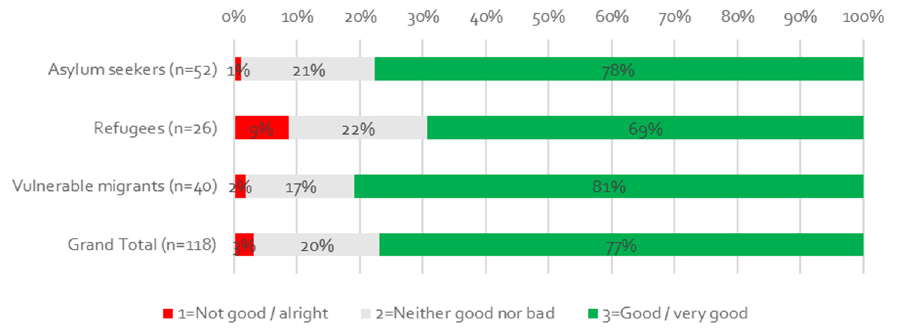
Figure 4. Average opinion for e ‐ portfolio.